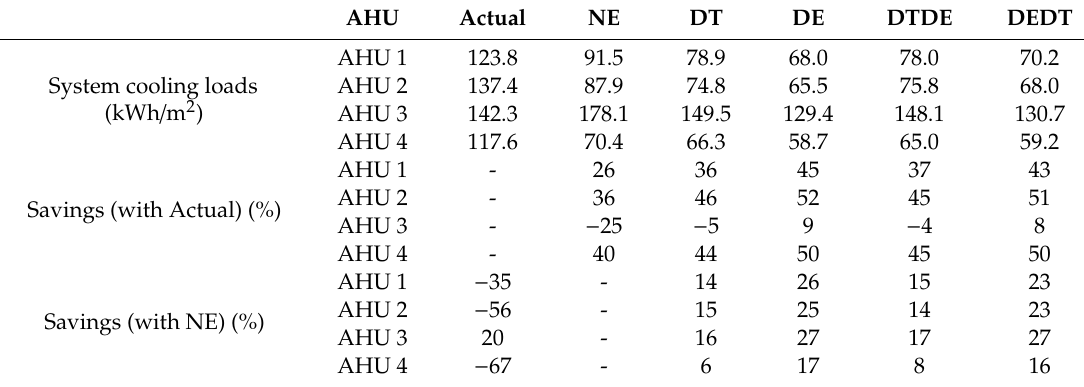
Table 6. Normalized system cooling loads and savings potential of economizer control